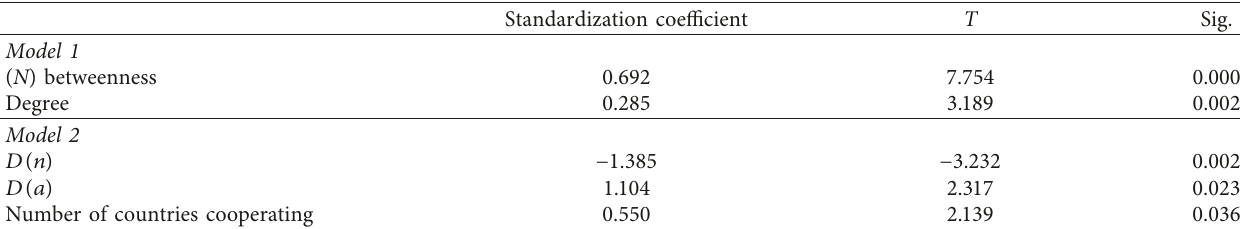
Table 13: Results of regression analysis. Standardization coefficient T